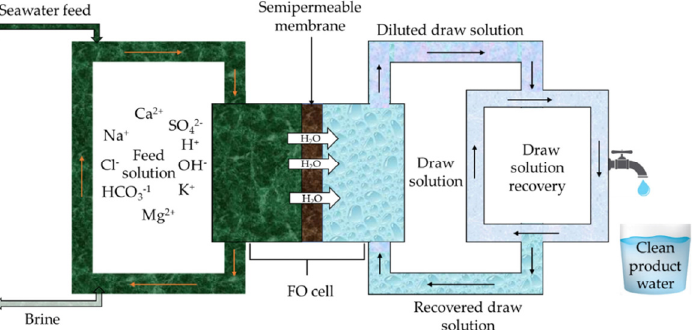
Figure 6. A schematic of the FO desalination process [98]. Image reused under the Creative Commons license.